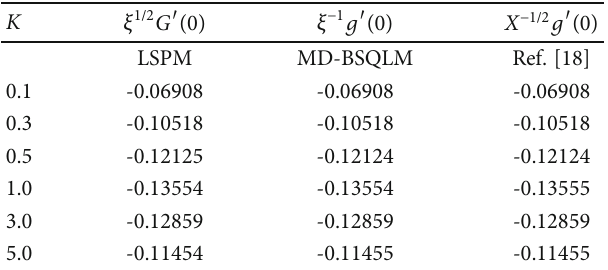
Table 1: Comparison of the LSPM and MD-BSQLM approximate numerical solutions against numerical values of Ref. [18] for X − 1/2 g ′ ð 0 Þ when X = 100 for di ff erent values of K when Pr = 10 , n = S = Ω = 0 , and He = 0 = N R